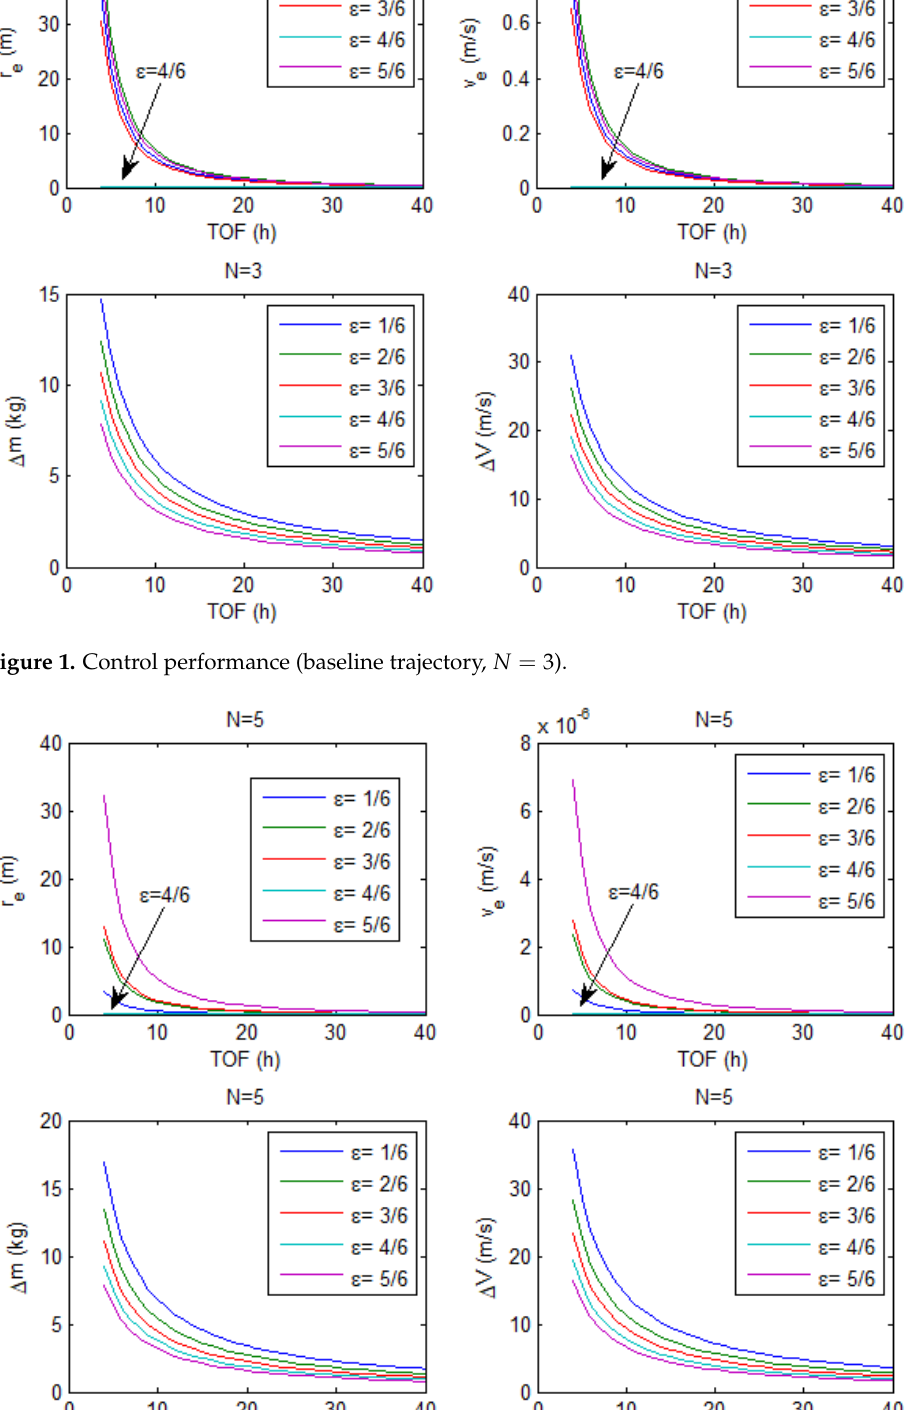
Figure 3. Control performance (baseline trajectory,